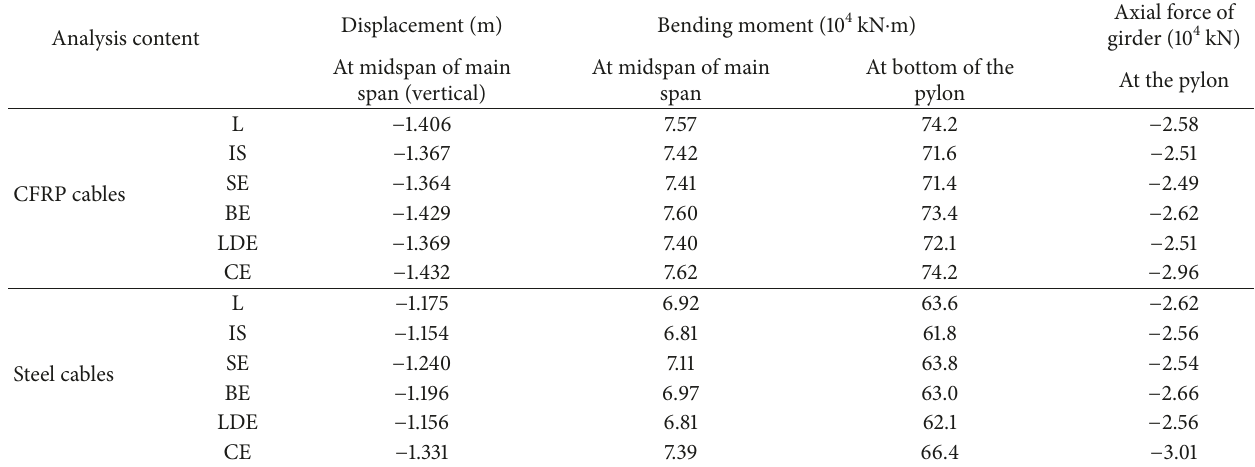
Table 3: Comparison of geometric nonlinear static